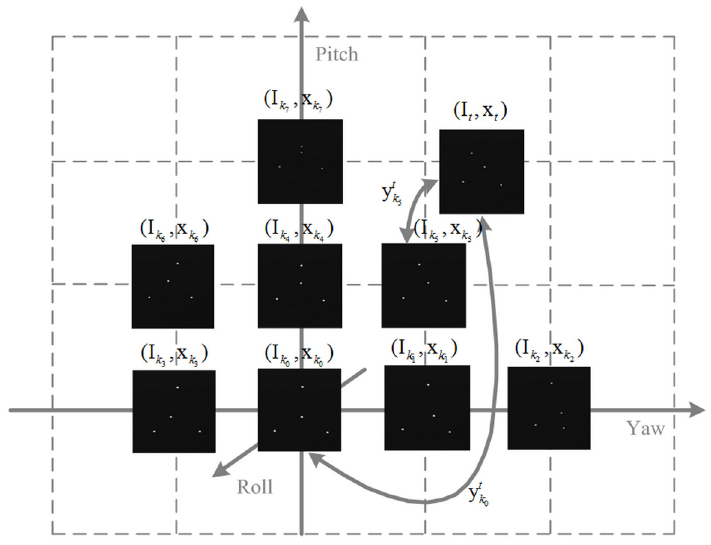
Fig 5. The schematic diagram of GCPC. FM i keeps control of the space around it. k i and t respectively represent the number of control point and measuring point. y j i is the measured value of pose vector between FM i and FM j